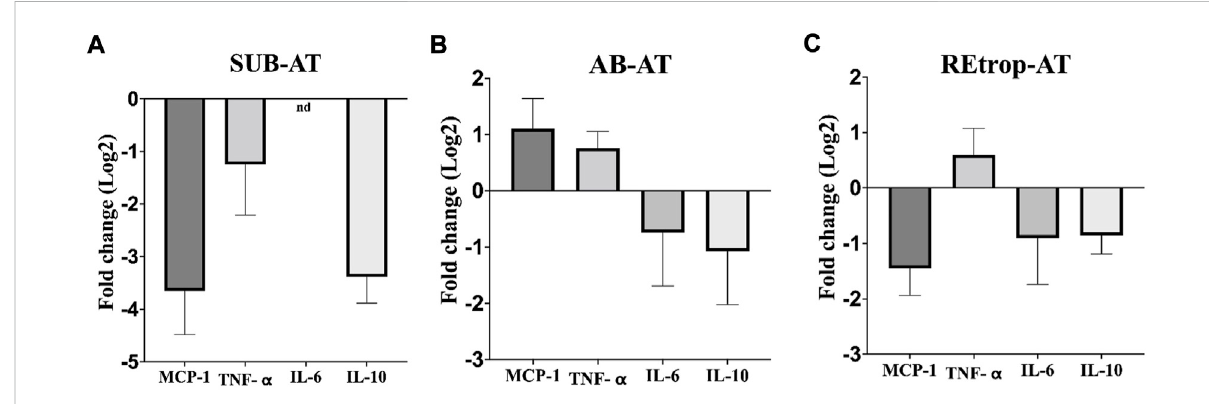
FIGURE 3 The expression level of MCP-1and the in fl ammatory mediators in three different adipose depots of male Sprague-Dawley rats. (A) Subcutaneous adipose tissue (SUB-AT), (B) Abdominal adipose tissue (AB-AT), (C) Retroperitoneal adipose tissue (REtrop-AT). Gene expression resultsweregeneratedusing2 − ΔΔ Ct method.Themeanfoldchange(log2)valuesofthetargetsmRNAexpressionwerenormalizedtocontrolsamples and the endogenous gene. signi fi cance: more than 2 fold change, compared to the control. (n = 6). nd, not detected.